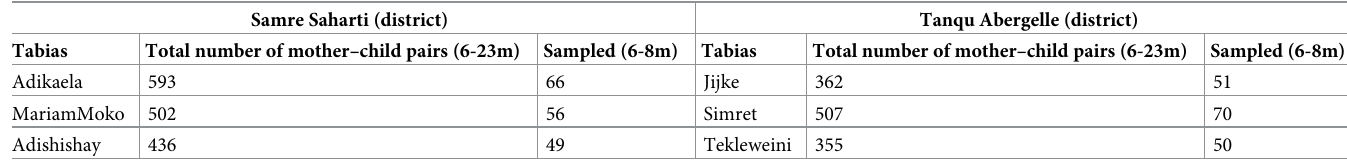
Table 1. Total number of samples from each study Tabia.